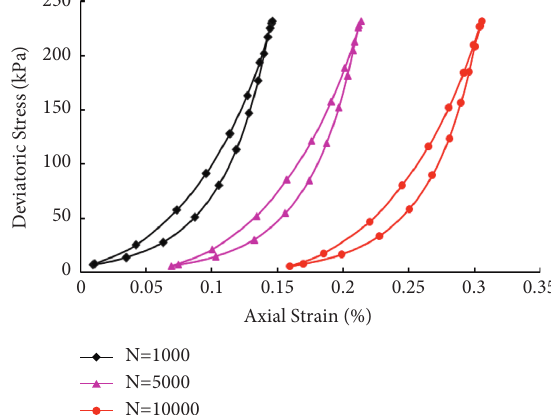
Figure 7: Hysteretic curve of different dynamic stress (cycle times N � 8000).